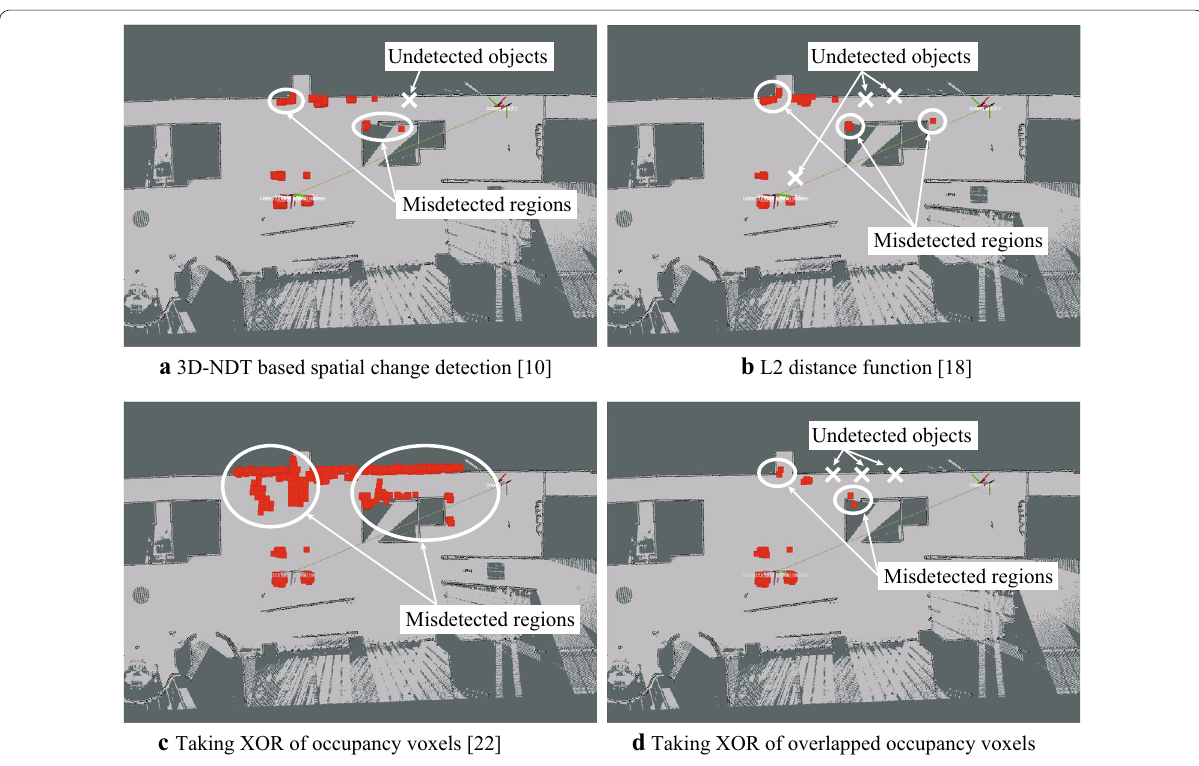
Fig. 11 Detected changes by a 3D-NDT based spatial change detection [10], b L 2 distance function [18], c taking XOR of occupancy voxels [22], and d taking XOR of overlapped occupancy voxels. Misdetected regions and undetected objects are indicated by white circles and crosses